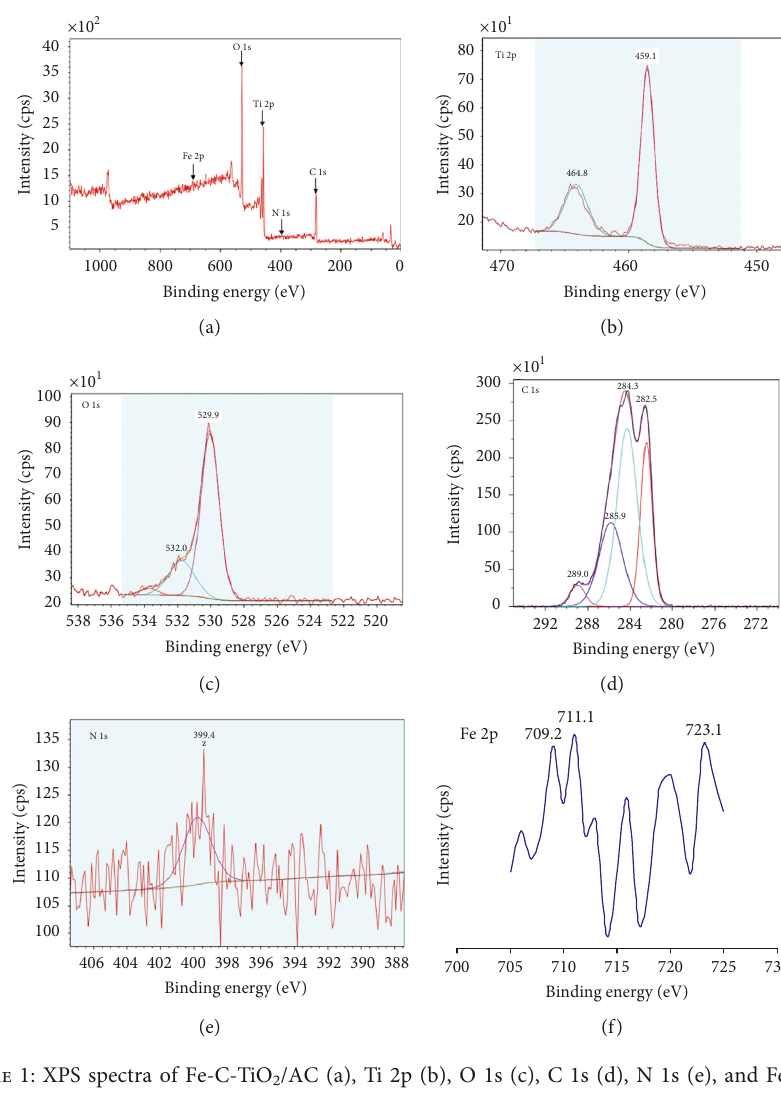
Figure 1: XPS spectra of Fe-C-TiO 2 /AC (a), Ti 2p (b), O 1s (c), C 1s (d), N 1s (e), and Fe 2p (f).